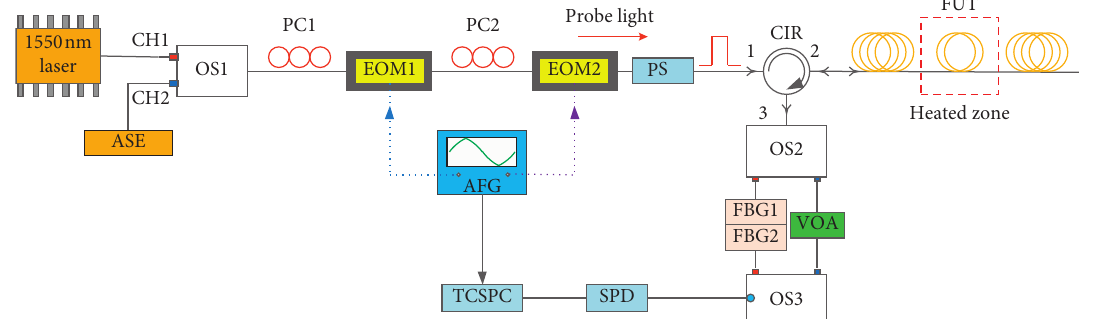
Figure 2: Experimental setup of distributed Brillouin temperature sensing system based on single-photon detector. EOM, electro-optic modulator; FUT, fiber under test; PC, polarization controller; AFG, arbitrary function generator; SPD, single-photon detector; FBG, fiber Bragg grating; VOA, variable optical attenuator; TCSPC, time-correlated single-photon counting; CIR, circulator; PS, polarization scrambler; OS, optical